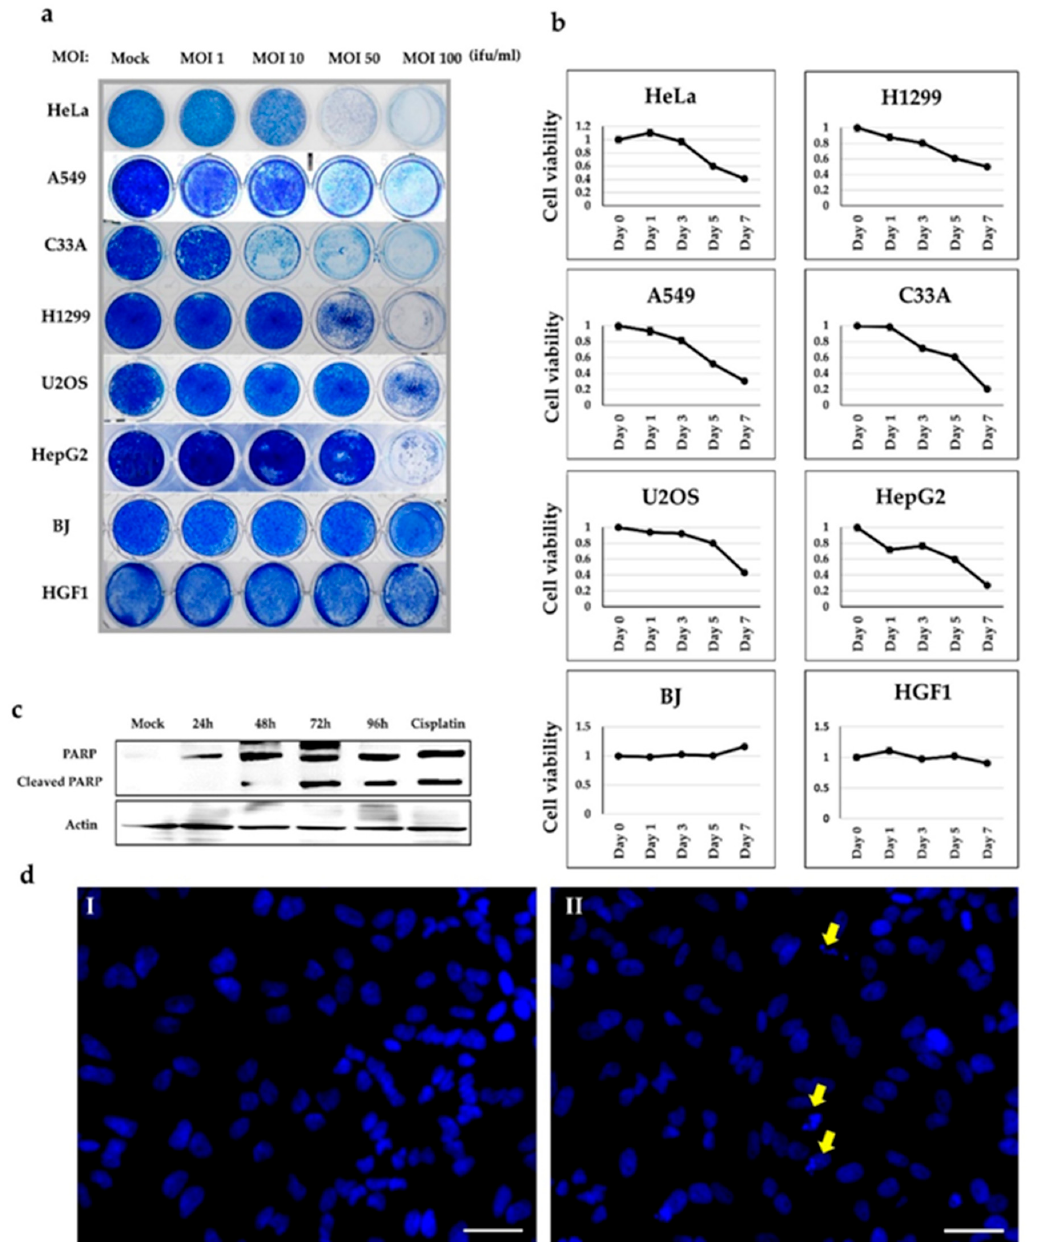
Figure 3. Cell lysis activity of Ad- fos ARE. ( a ) Cancer (HeLa, A549, C33A, H1299, U2OS, and HepG2) cells and normal (BJ and HGF1) cells were infected with the virus at MOIs indicated. Cells were stained using Coomassie brilliant blue 7 days post-infection. Living cells stained blue. ( b ) Cell metabolic activities of Ad- fos ARE-infected cells were measured to estimate the cell lysis activity using the XTT assay. The same cancer and normal cells were infected with the virus at a MOI of 100 ifu/cell and cell viabilities were estimated 1, 3, 5, and 7 days post infection. ( c ) Cleaved PARP levels were assessed by western blot analysis to detect the cell death activity mediated by Ad- fos ARE. PARP expression in cisplatin-treated cells were used as a positive control [34]. ( d ) HeLa cells were infected with Ad- fos ARE with MOI 100 ifu/cell. The apoptosis of cells was also analyzed by Hoechst 33,342 staining 96 h after infection. Nuclear fragmentation and chromatin clumping were observed in the virus treated cells (Yellow arrows). Scale bar: 50 µm. Three replicates represented each assay.